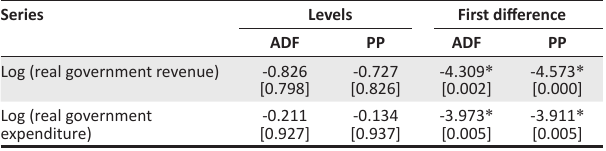
TABLE 5: Results of unit root tests.